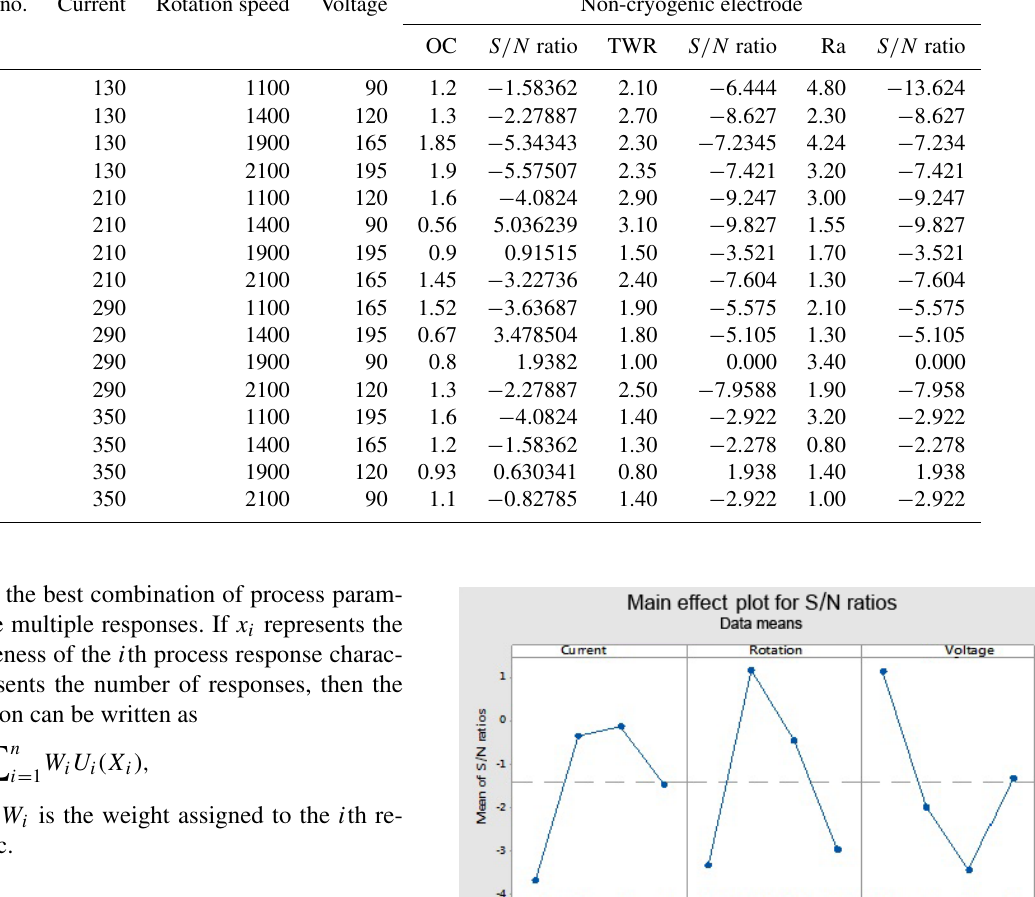
Table 4. Orthogonal array with performance for simple (non-cryogenic) electrode. Experiment no.